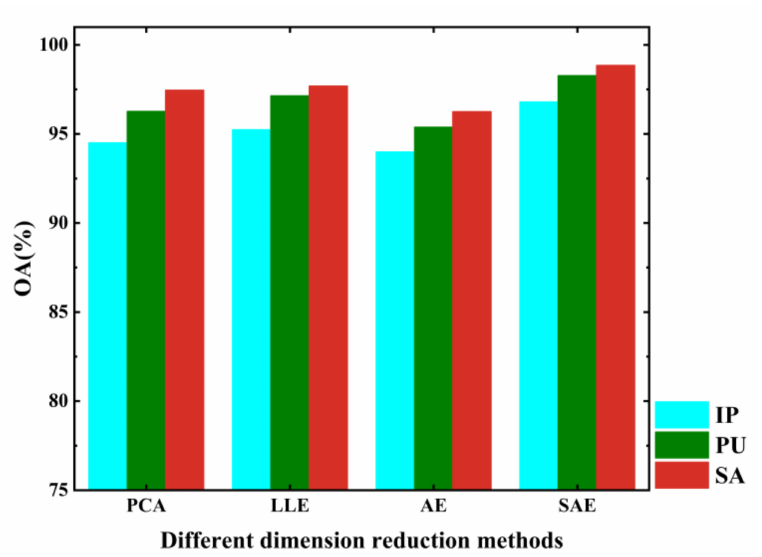
Figure 16. Comparison of OA using four dimension-reduction methods for three